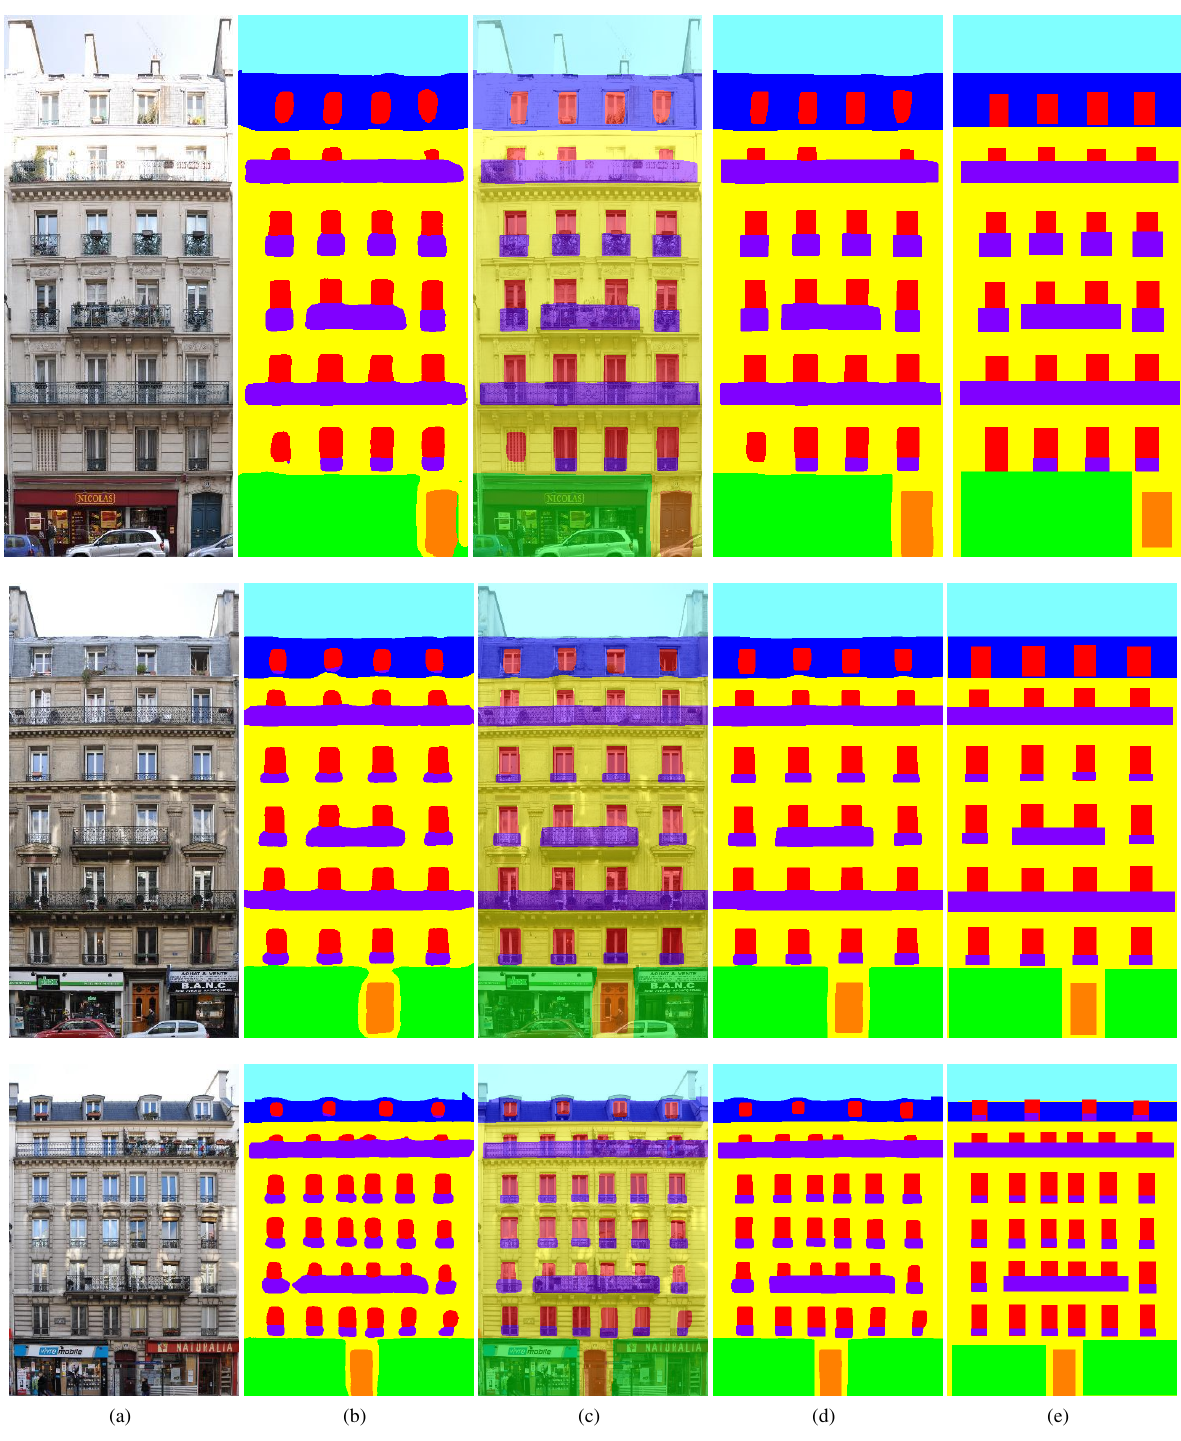
Figure 4. Qualitative results on the ECP dataset. The facade segments are homogeneous and nearly without noise. Column (a) input images, (b) results from Structured Random Forests, (c) results after 10 iteration of the optimization algorithm mapped in the input images, (d) results after 50 iterations of the algorithm, (e) ground truth. Colors see Fig.